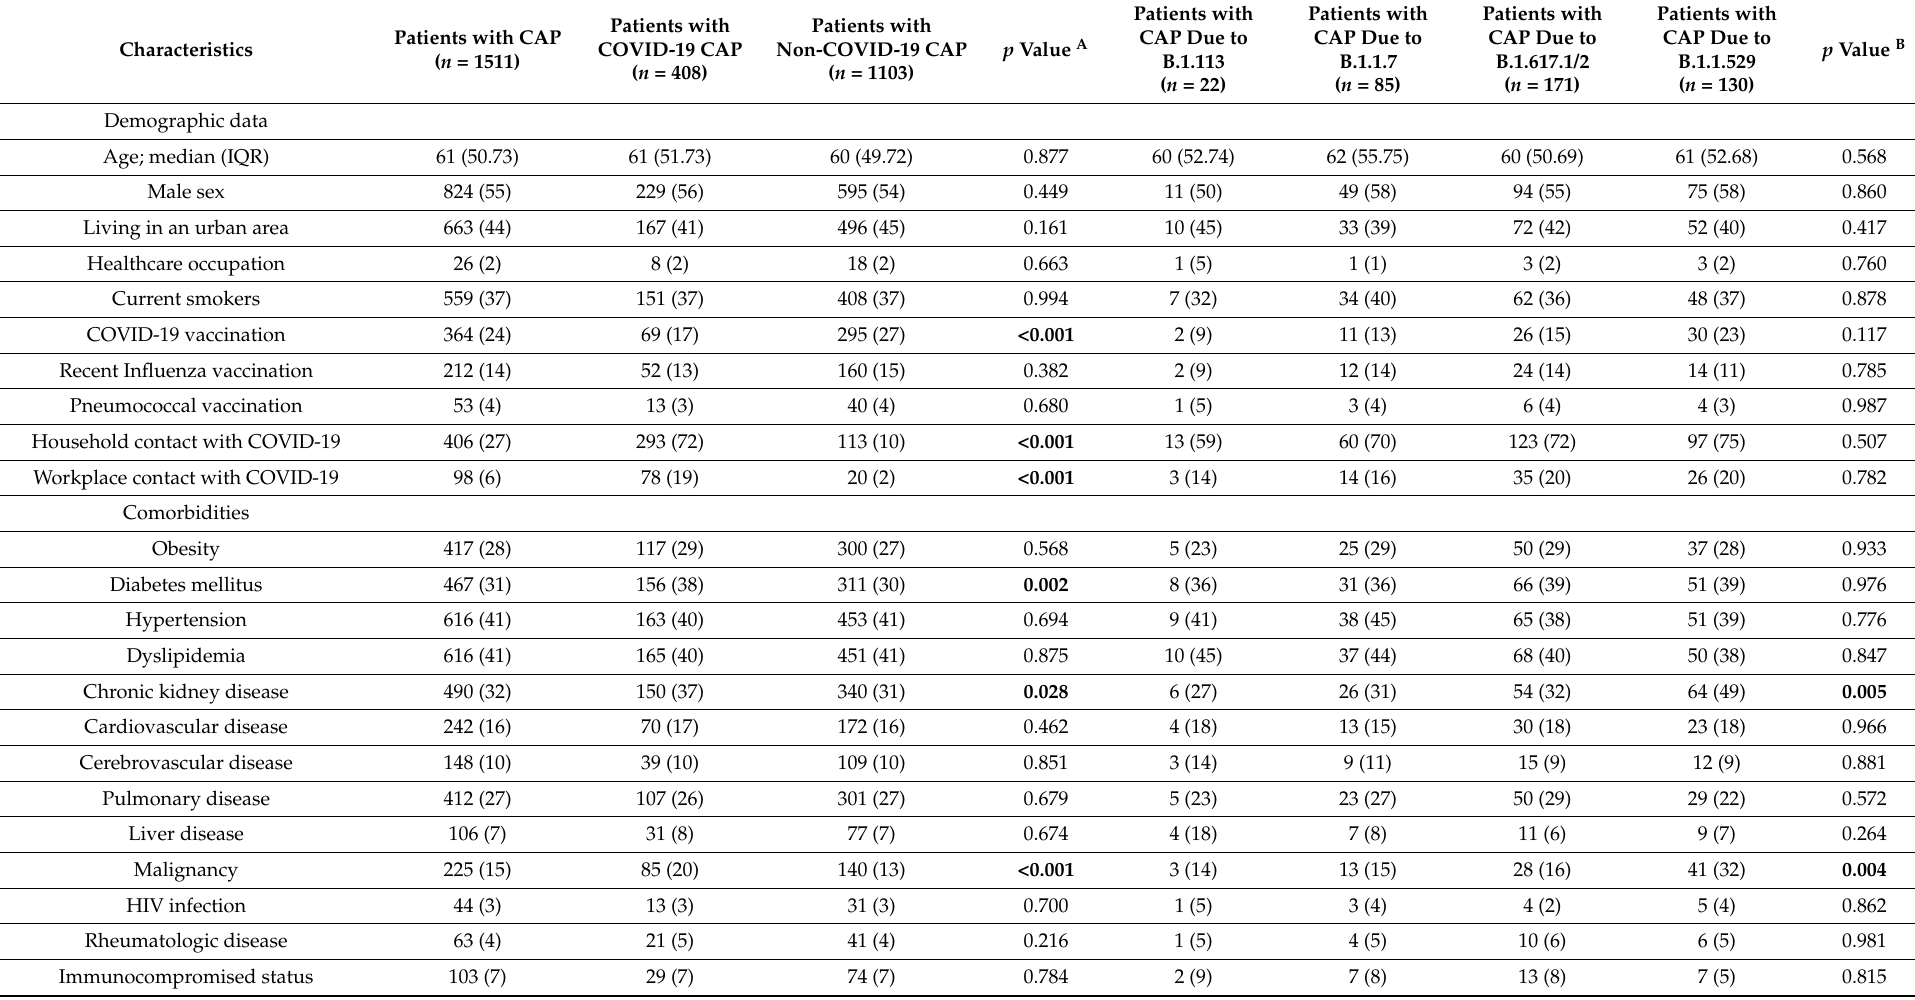
Table 2. Characteristics of patients with community-acquired pneumonia (CAP) and comparison between CAP due to coronavirus disease 2019 (COVID-19) and CAP due to